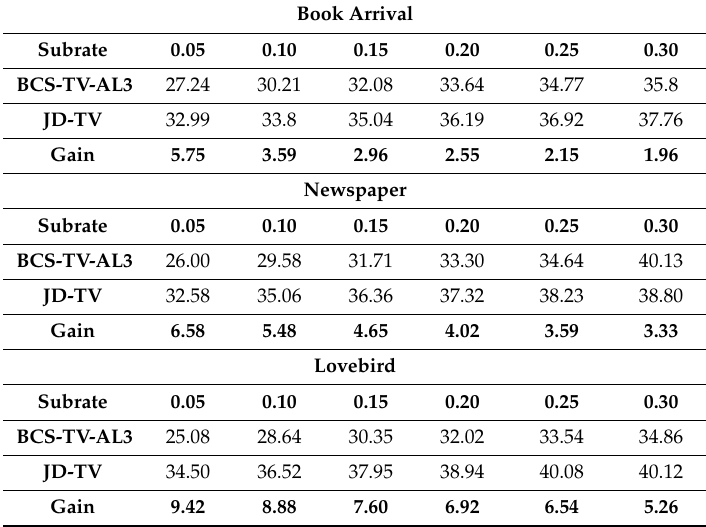
Table 5. Average PNSR evaluation of proposed JD-TV scheme and the independent BCS-TV-AL3 for di ff erent HD video sequences at various subrates having GoP = 8.